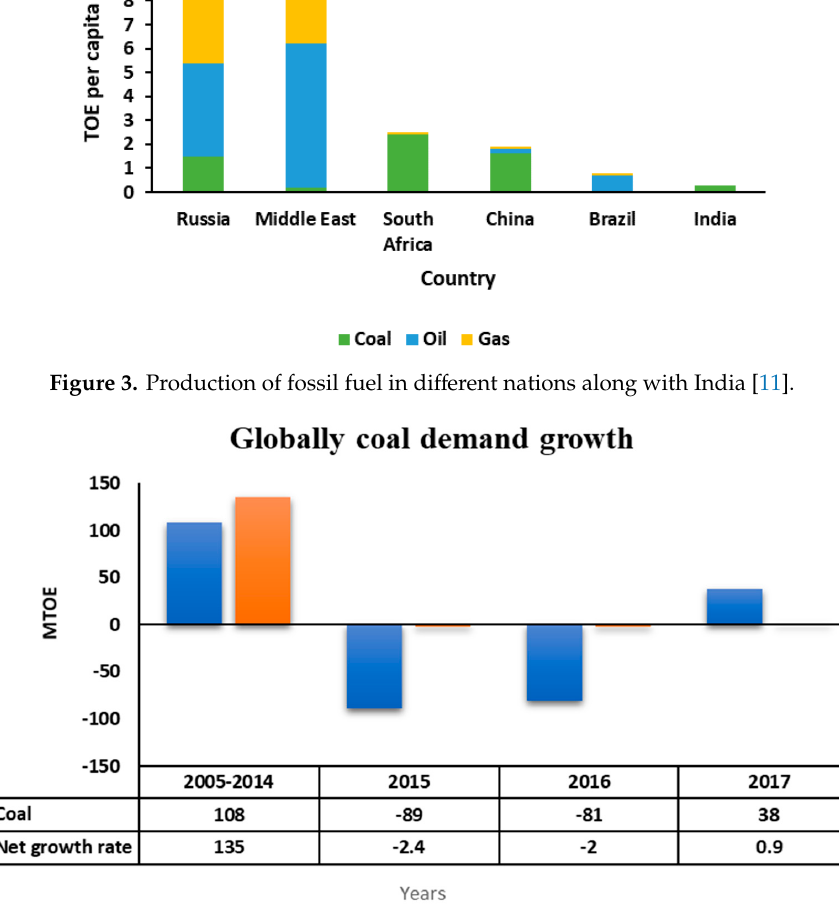
Figure 4. Trends for the production of domestic coal in India [12].